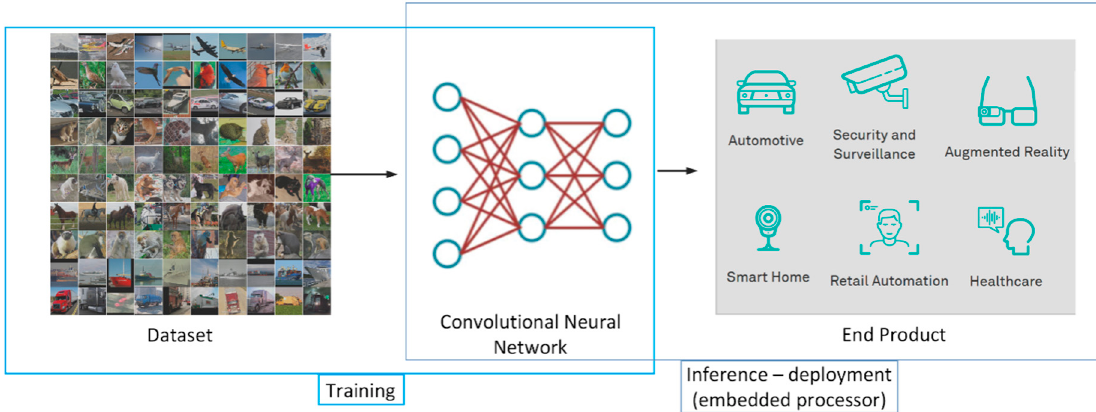
Figure 3. General deep learning development flow. Training—once the convolutional neural network model is developed it is trained with the appropriate dataset. Inference—the trained model is deployed at the end product and used for inference with real-time input data.